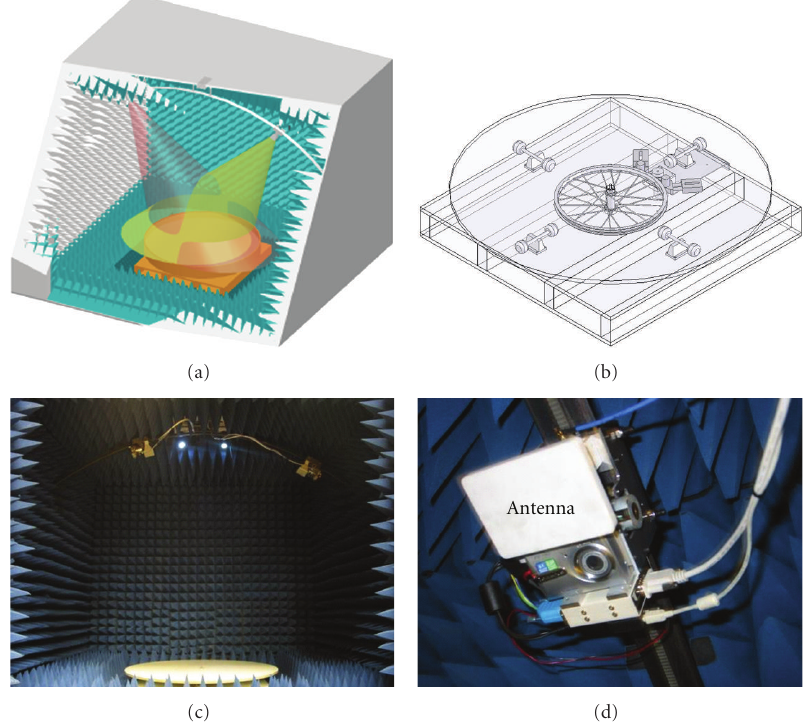
Figure 2: (a) Cutaway schematic of anechoic chamber showing transmit and receive beams. (b) Schematic of turntable. (c) View of anechoic chamber through open doors. (d) Close-up view of antenna trolley showing camera and antenna.